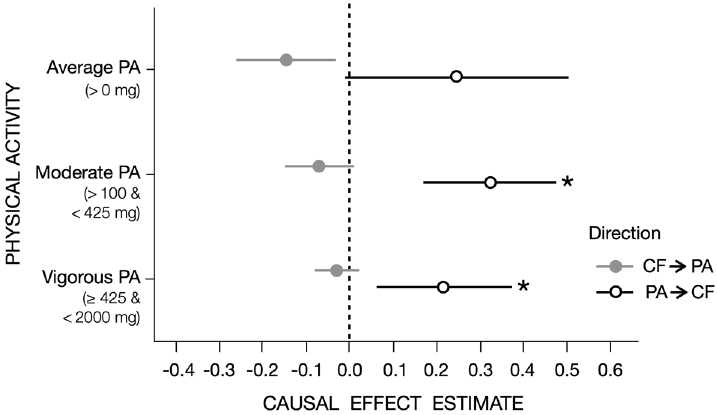
Figure 3. LHC-MR plots for the association between accelerometer-based physical activity and general cognitive functioning, Notes , This modified dot-and-whisker plot reports the causal estimate between general cognitive functioning (CF) as exposure and varying physical activity (PA)-related traits as outcomes. The forward (CF → PA) and reverse (PA → CF) causal estimates are shown in two different colors as dots (grey and white) with 95% CI whiskers (grey and black). Average PA = average of overall accelerations > 0 mg. Moderate PA = fraction of acceleration corresponding to moderate physical activity (> 100 mg and < 425 mg). Vigorous PA = fraction of acceleration corresponding to vigorous physical activity (≥ 425 mg and < 2000 mg). The models were adjusted for age, sex, genotyping chip, first ten genomic principal components (PC), center, and season (month) of wearing accelerometer. * = significant effect after Boneferroni correction (i.e., P -value <